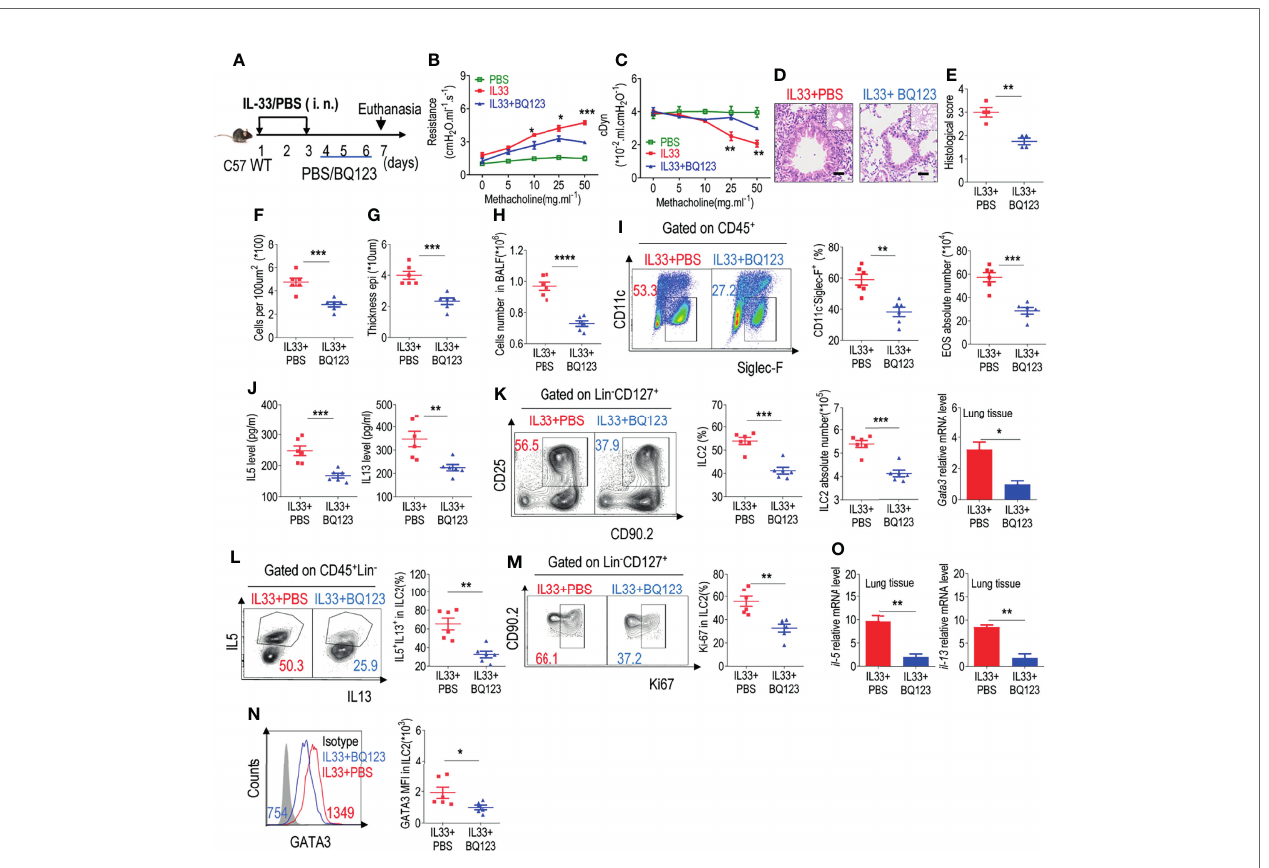
FIGURE 3 | BQ123 exerted a potential therapeutic effect on allergic in fl ammation. (A) Experimental scheme. Six-week-old C57BL/6J mice were challenged intraperitoneally with rmIL-33 (0.5 µg) on days 1 – 3. Subsequently, the mice were treated intraperitoneally with BQ123 or PBS control for three days and were sacri fi ced 24 h after the last injection on day 7. (B, C) Line graphs show lung resistance and dynamic compliance (cDyn) in response to increasing doses of methacholine. (D – G) Representative hematoxylin and eosin (H&E) staining of lung sections (D) and in fl ammation scores (E) , as well as the in fi ltrating cells (F) and airway epithelium thickness (G) were shown. Bars, 100 m m. Absolute number of BALF (H) , typical example of fl ow cytometry and statistical results, the absolute number of EOS in the BALF (I, J) Levels of IL-5 and IL-13 in the BALF were shown. (K – N) Representative results of fl ow cytometry and statistical analysis of the frequencies of ILC2s and absolute counts (K) , IL-5 + IL-13 + ILC2s (L) , Ki67 + ILC2s (M) , and levels of GATA3 protein (N) in the lungs were indicated. (O) The mRNA expression levels of ILC2-related target genes in lung tissues, including Il5, Il13 , and Gata3 , were determined; b -actin level was used for normalization, and the lowest expression level in the IL33 + BQ123 group was arti fi cially set to 1 (n=3). Data are representative of two or three independent experiments (n = 6 for IL33 + PBS group; n = 6 for the IL33 + BQ123 group). Note: *P < 0.05; **P < 0.01; ***P < 0.001; ****P < 0.0001. In all panels, individual results and mean ± standard error of the mean (SEM) are shown; statistical signi fi cance was determined using a two-tailed unpaired Student ’ s t-test (B, C, E – O)